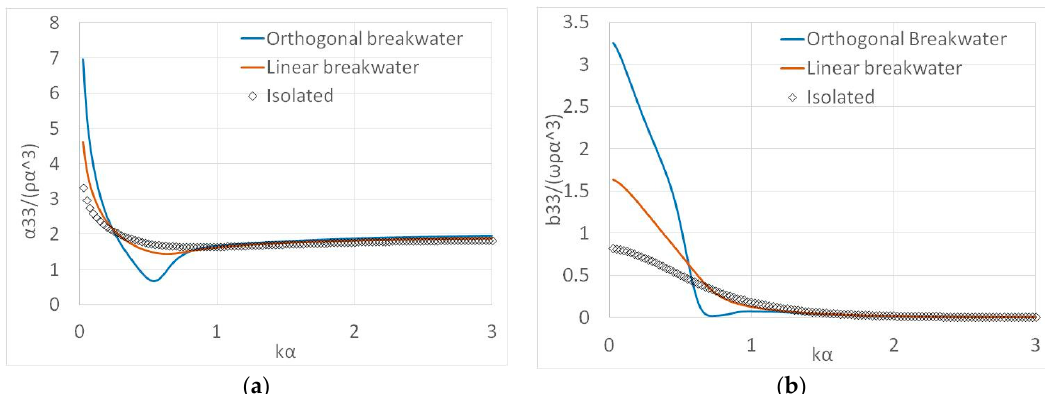
Figure 11. Exciting forces on a floating cylindrical floater placed in front of a linear breakwater using the method of images: ( a ) horizontal-exciting force on x -axis; ( b ) horizontal-exciting force on y -axis; ( c ) vertical-exciting force on z -axis. The results are compared with the corresponding values of the same floater placed in front of a right-angle-shaped breakwater and in isolation condition (i.e., without the presence of the breakwater).